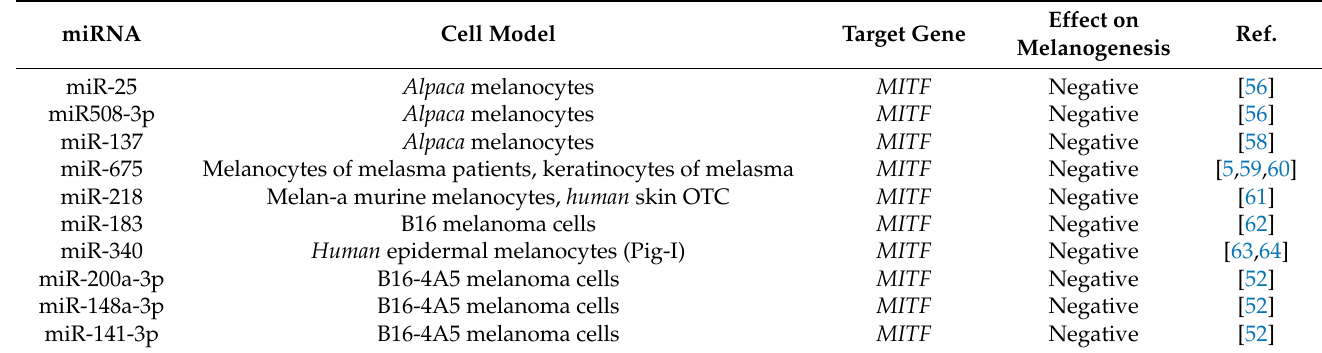
Table 1. microRNAs regulating MITF in